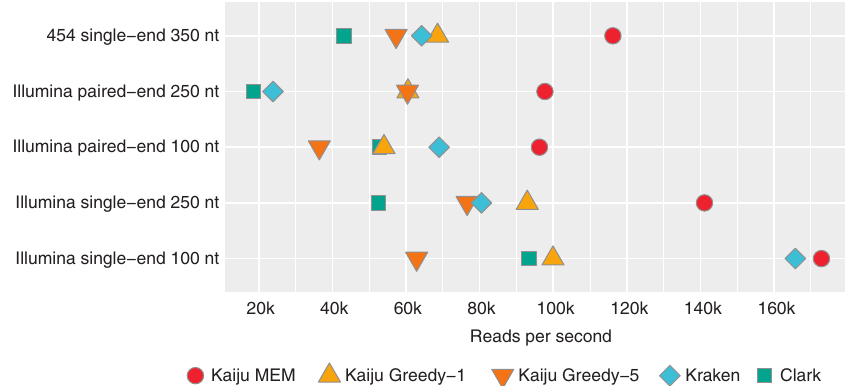
Figure 4 | Classification speed. Performance was measured in processed reads per second for each program using 25 parallel threads for classifying a set of 27.24m simulated reads for the five different read